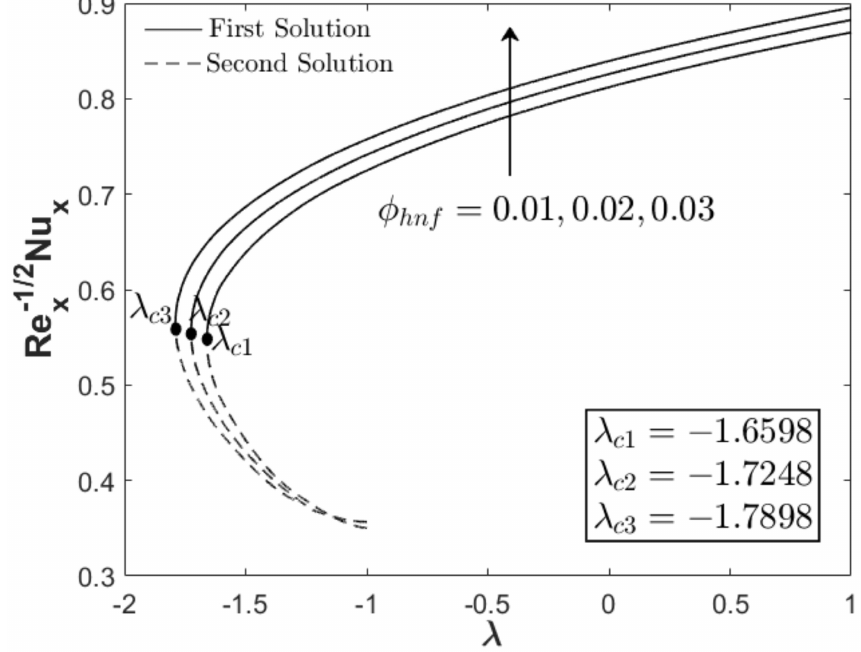
Figure 7. Re − 1/2 x Nu x towards λ when m = 0.3, S = 0.05, and different φ hnf . Table 3. Comparison of Re 1/2 x C f with different value of φ 2 when λ = S = 0. φ 2 Present Waini et al. [28] Waini et al. [48] 0 1.2968902 1.296890 1.296890 0.25 1.5538496 1.553850